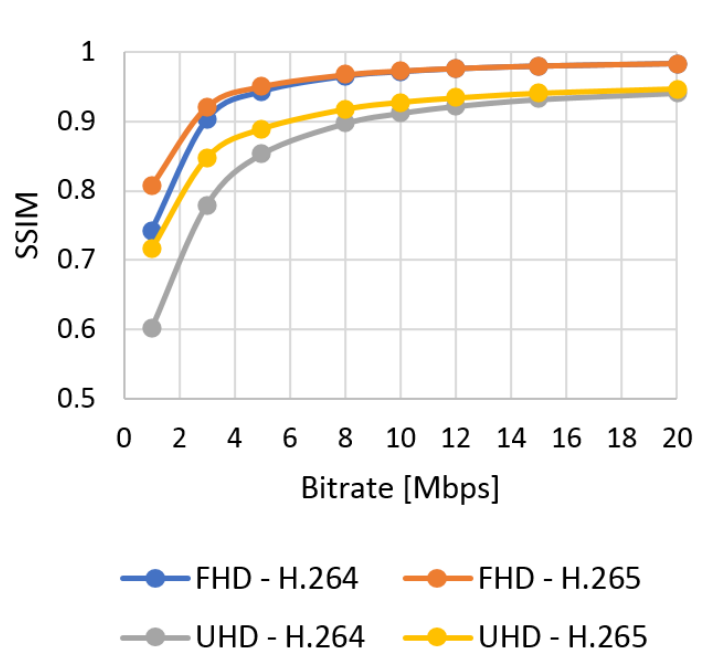
Figure 14. Bund Nightscape, objective evaluation.